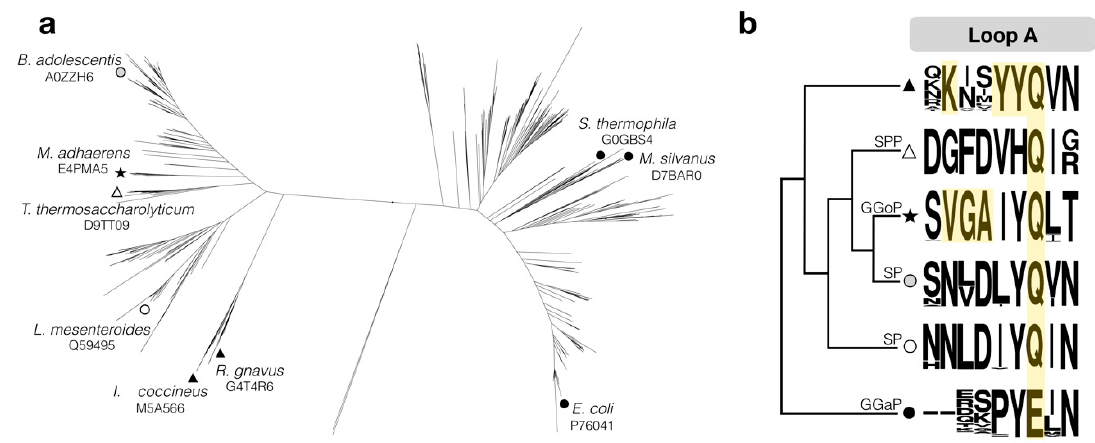
Figure 1. ( a ) Phylogenetic tree of protein sequences classified in subfamily GH13_18. A selection of representatives that have been characterized and reported in the literature are indicated with their UniProt ID. ( b ) Simplified phylogenetic tree showing the sequence logo of an acceptor site loop for the proteins in the branch. Motifs mentioned in the main text are highlighted. Black triangle, IcSPP-like sucrose 6 F -phosphate phosphorylases (target clade in this study); white triangle, TtSPP-like sucrose 6 F -phosphate phosphorylases; star, glucosylglycerol phosphorylases (GGoP); grey circle, Bifidobacterium -like sucrose phosphorylases; white circle, lactic acid bacteria-like sucrose phosphorylases; black circle, glucosylglycerate phosphorylases (GGaP).